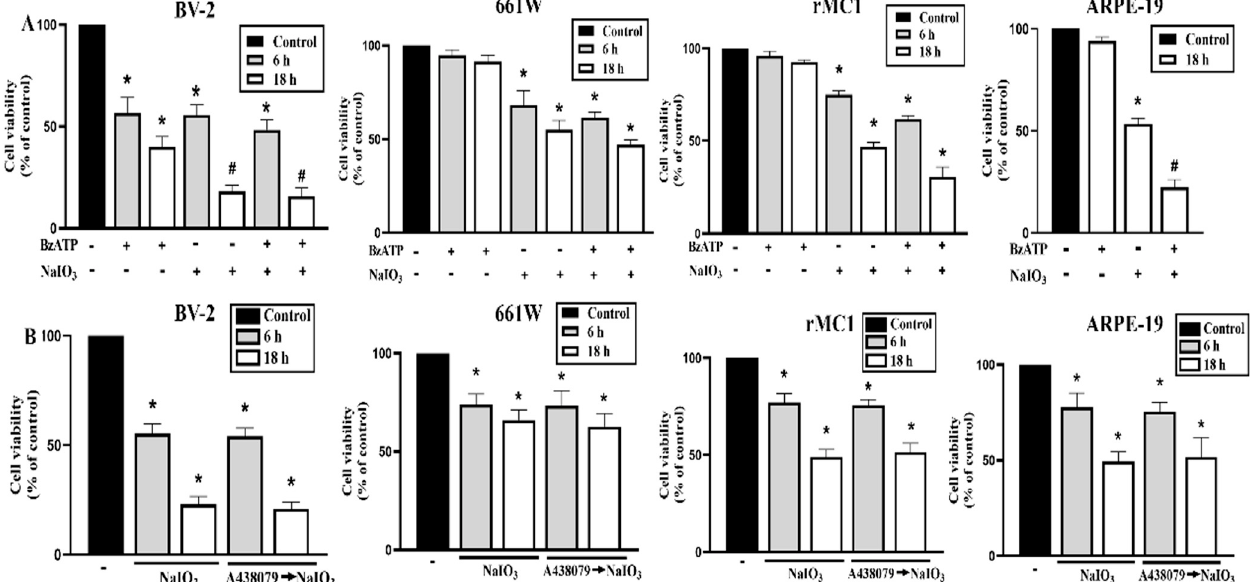
Figure 8. Effects of BzATP and A438079 on NaIO 3 -induced cell death in retinal cells. BV-2, 661W, rMC1 and ARPE-19 cells were treated with BzATP (200 μ M) ( A ), A438079 (10 μ M) ( B ) and/or NaIO 3 (30 mM) ( A , B ) for 6 or 18 h. Cell death was determined by Annexin V/PI staining with FACS. * p < 0.05, significant inhibition of cell viability. # p < 0.05, an additive cytotoxicity was observed upon NaIO 3 and BzATP co-treatment in ARPE-19 cells.